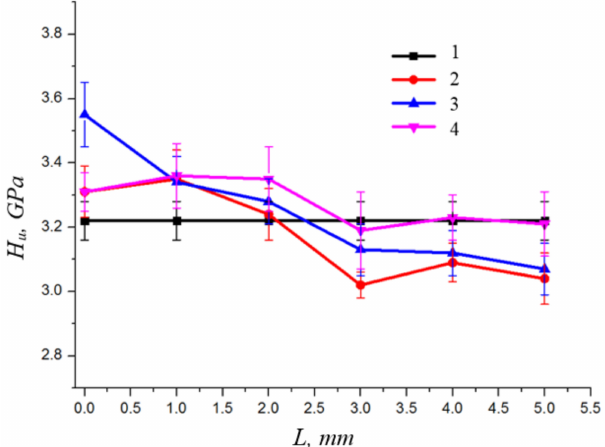
Figure 3. Microhardness measurements of investigated specimens from alloy VT23 in the initial state initial state (1), under static stretching (2), DNP1 (3), and DNP2